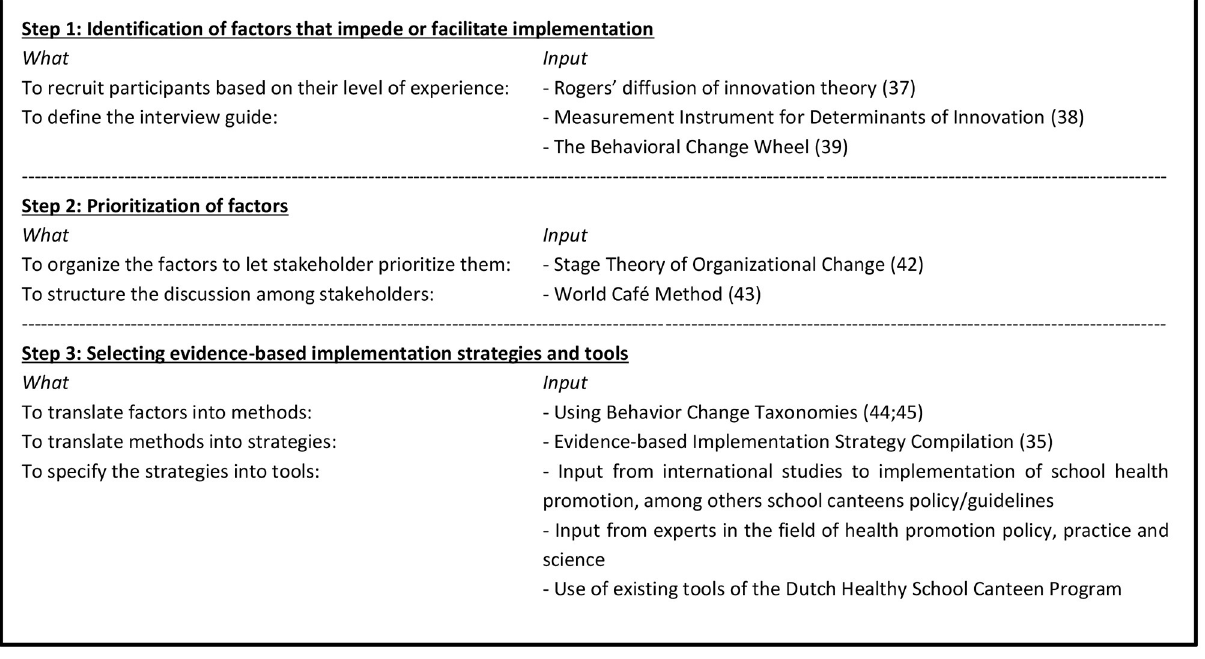
FIGURE 1 | The three-step approach used to develop the implementation